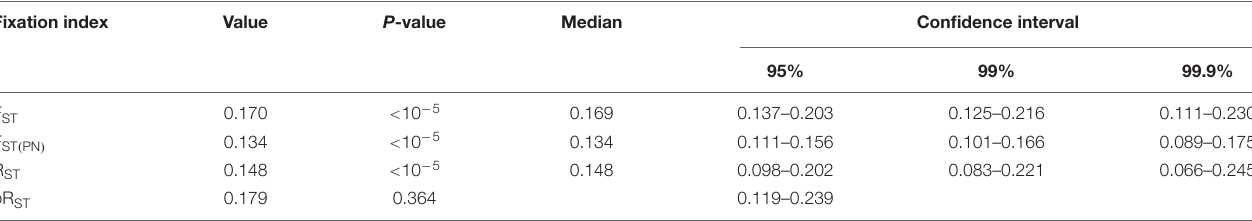
TABLE 1 | Genetic divergence (F ST , R ST ) among the five groups of varieties of cultivated globe artichoke as determined by AMOVA over loci considering two sources of variation: among populations and among individuals within populations. Fixation index